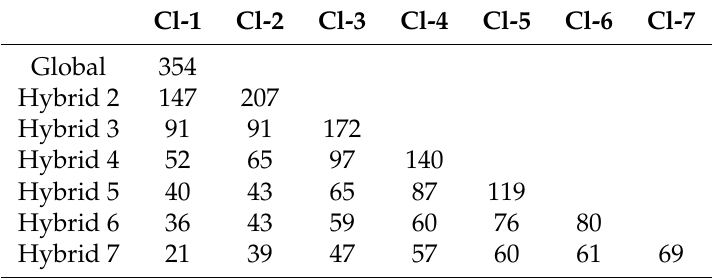
Table 2. Number of samples per cluster in the model to predict the power at 15:00.